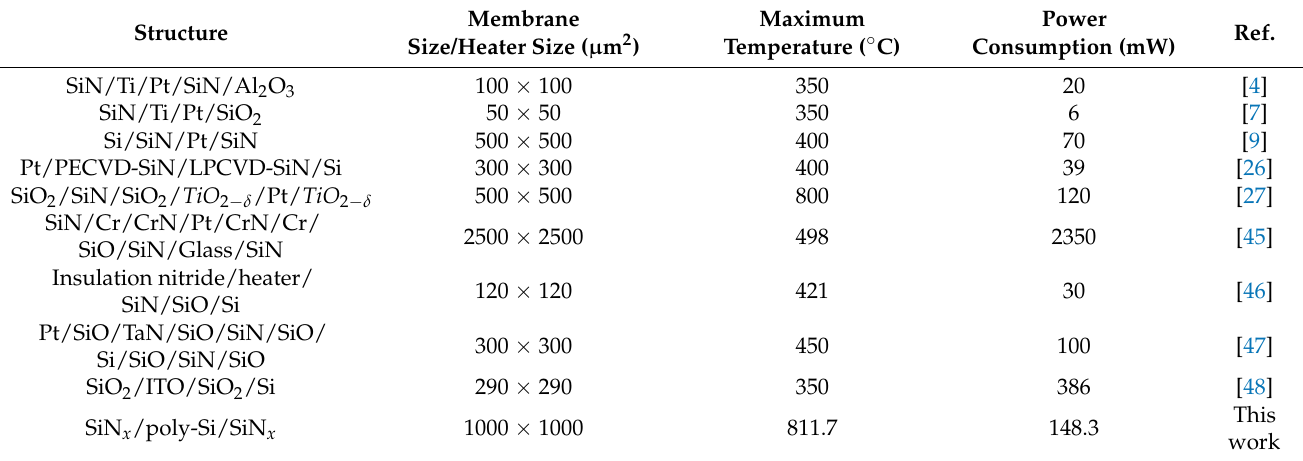
Table 1. Comparison of various